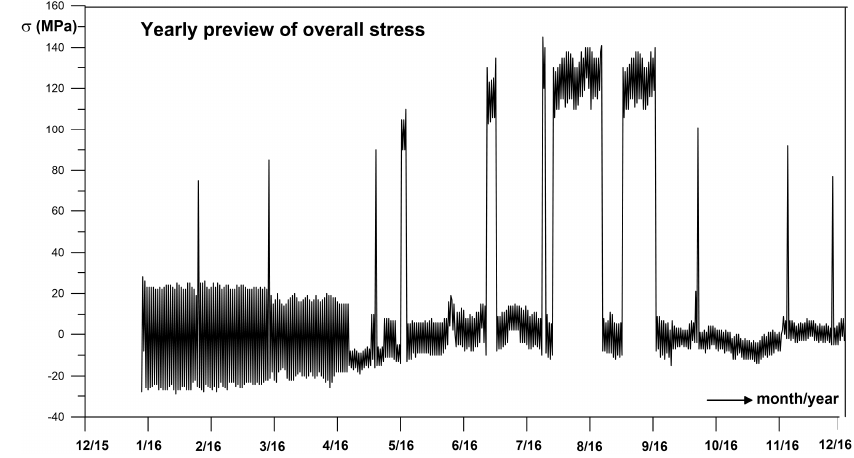
Figure 7. The progress of daily stress peaks in the cross-section of the pipe near the compressor obtained by a monitoring system with an extended thermal and device compensation concept.